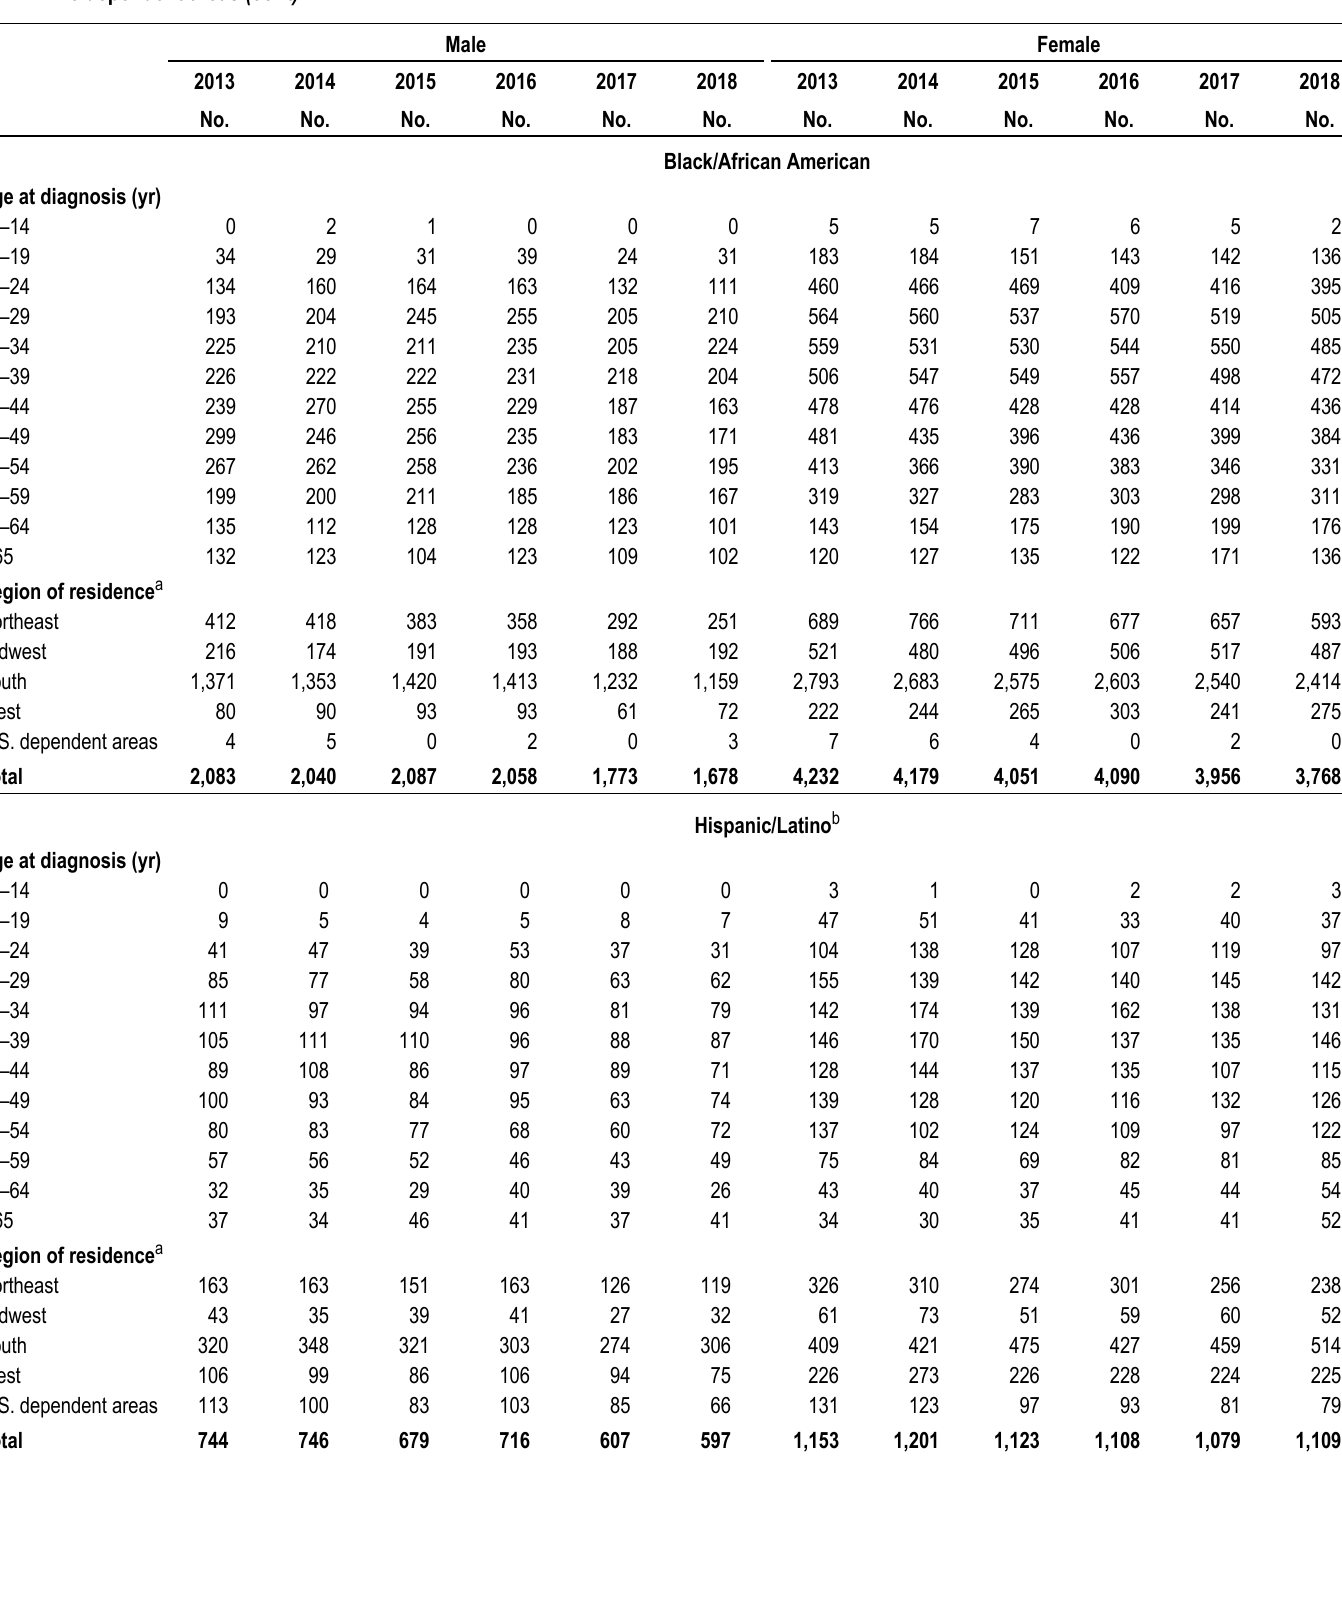
Table 9b. Diagnoses of HIV infection attributed to heterosexual contact, by selected characteristics, 2013–2018—United States and 6 dependent areas